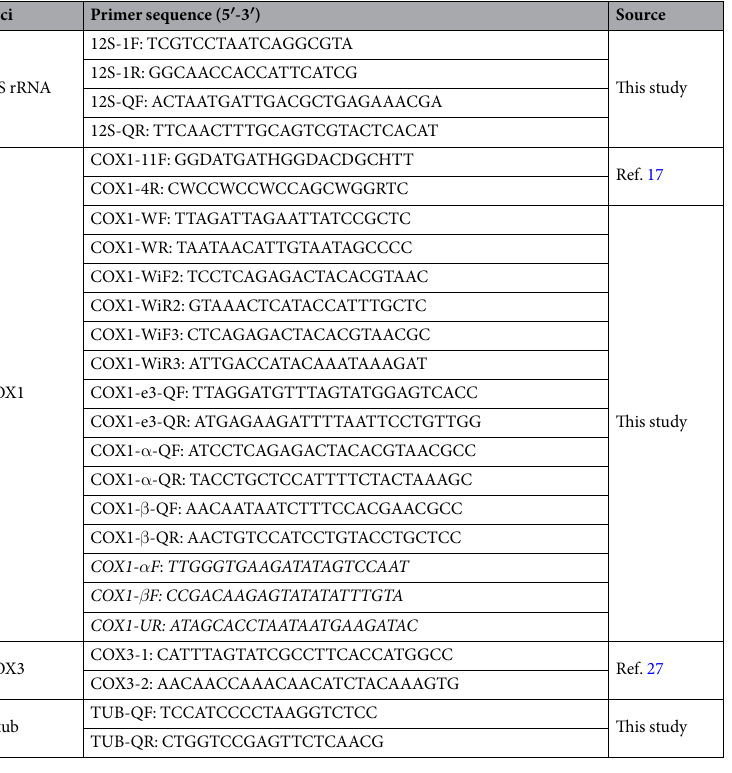
Table 2. PCR primers used in this study. Italicized primers indicated the genotyping primers for the “ α ” and “ β ” type COX1 fragments. Primer names with letter “Q” means they are for qPCR. COX1-e3: primers for detecting COX1 exon